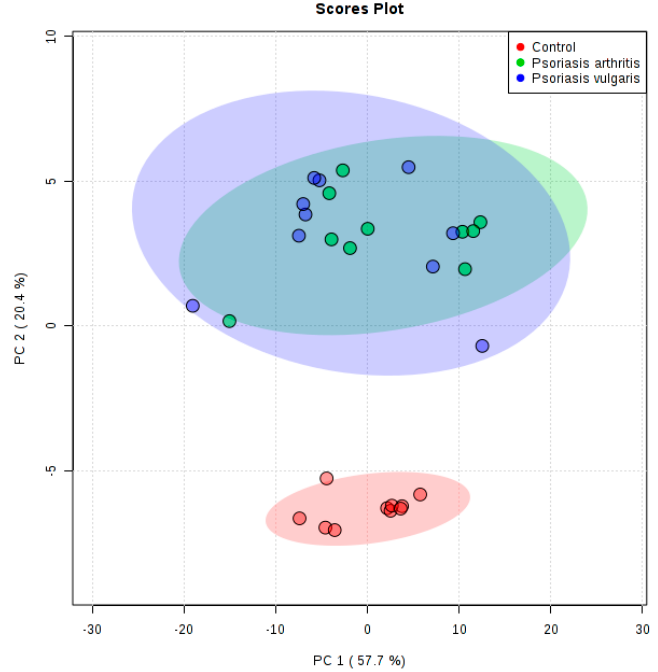
Figure 1. Principal component analysis (PCA) plot of the phospholipid species relative abundance determined by HILIC-LC-MS in lymphocytes of patient with psoriasis vulgaris (n = 10) and psoriatic arthritis (n = 10) as well as healthy subjects (n = 10); 95% confidential intervals are indicated by shaded area.